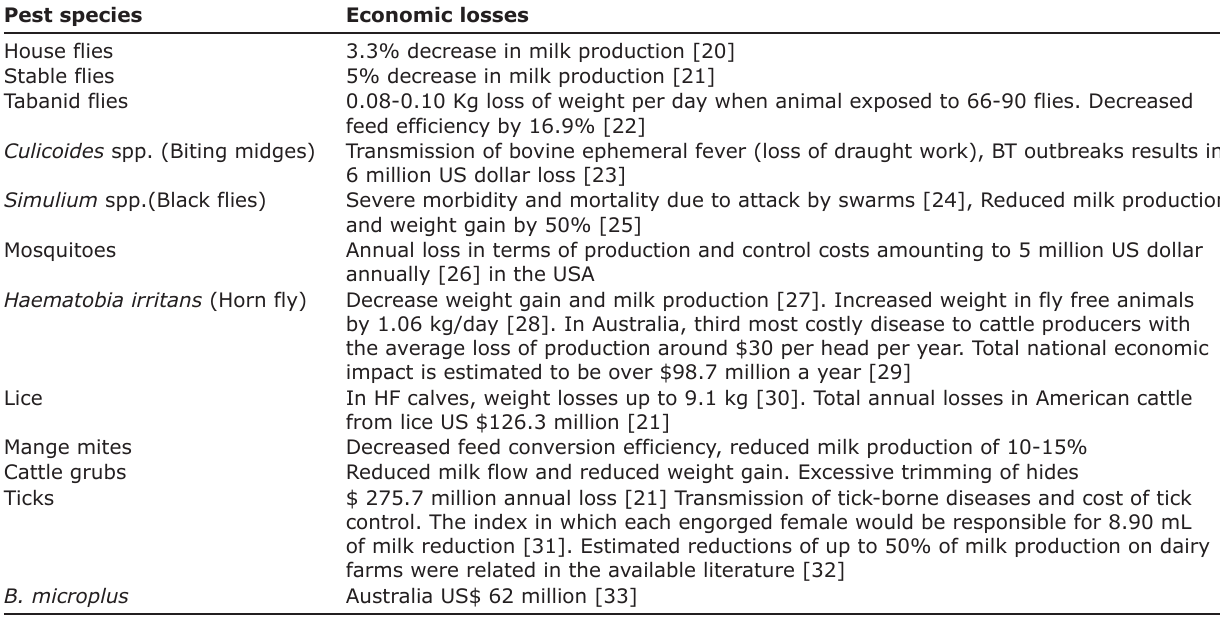
Table-1: Effect of vectors-cum-pests on production from livestock resulting in a reduction in economic gains. Pest